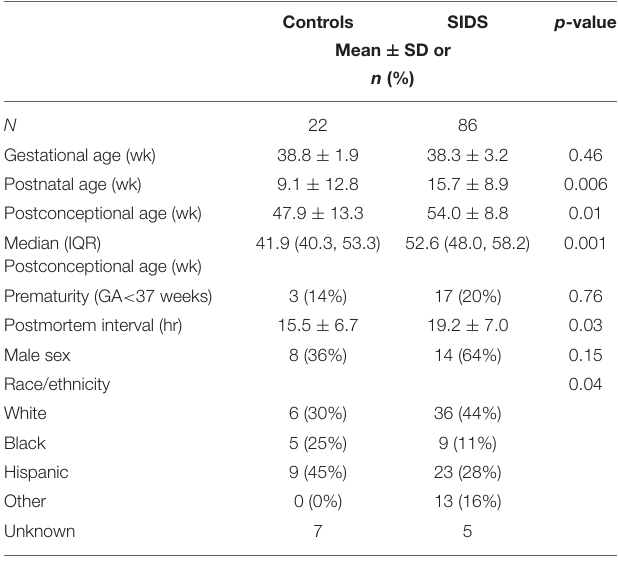
TABLE 1 | Demographics of the SIDS and control cases comprising the full combined cohort for 5-HT 1A binding analysis.